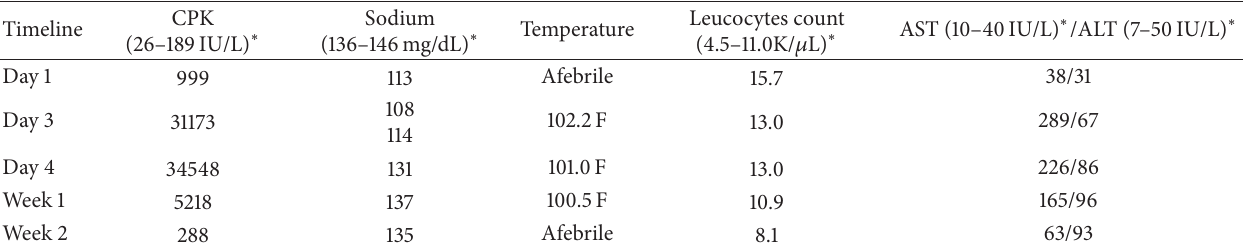
Table 1: Timeline changes in creatine phosphokinase (CPK) and sodium